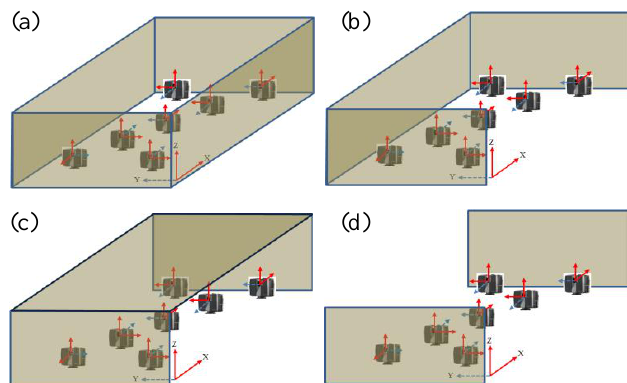
Figure 5. Reducing number of surfaces for targets distribution, (a) Four surfaces by removing a ceiling, (b) Three surfaces by removing a ceiling and a length wall, (c) Three surfaces by removing both length walls and (d) two surfaces.